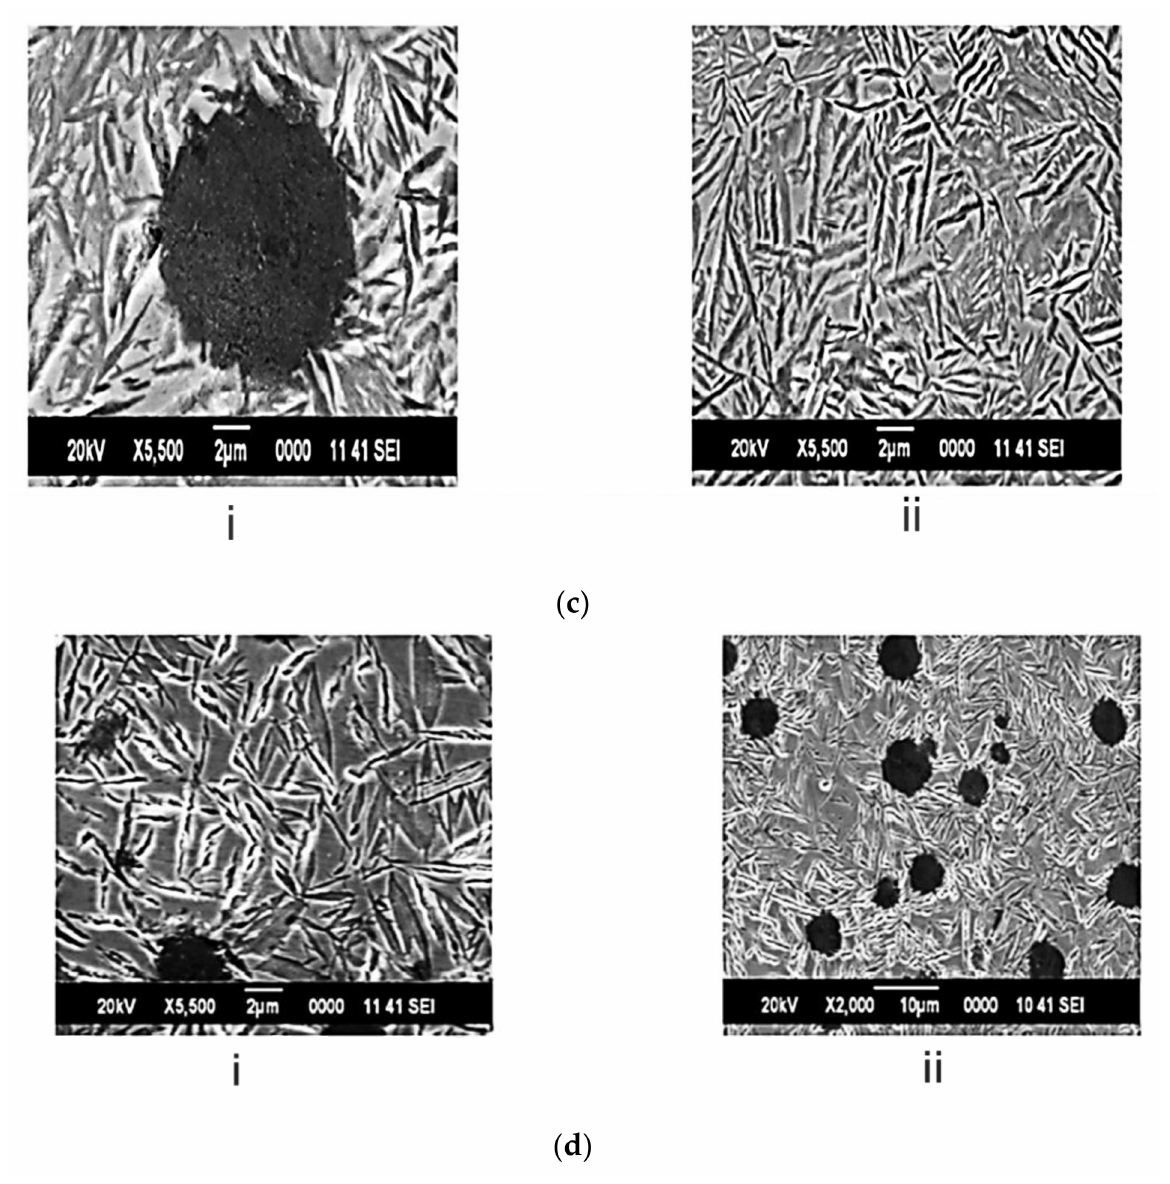
Figure 4. ( a ) Unetched microstructure of ductile iron. ( b ) Microstructure of 2 mm thick plate austempered at 400 ◦ C; kept for ( i ) 2 min, ( ii ) 5 min, and ( iii ) 10 min; and inoculated with Ce-Ca-Al- S-O-FeSi at 0.4%. ( c ) SEM micrograph of 2 mm thick plate austempered at 400 ◦ C and kept for 2 min ( i ) around nodule and ( ii ) in matrix inoculated with Ce-Ca-Al-S-O-FeSi at 0.4%. ( d ) SEM micrograph of 2 mm thick plate austempered at 400 ◦ C and kept for 10 min ( i ) around nodule and ( ii ) in